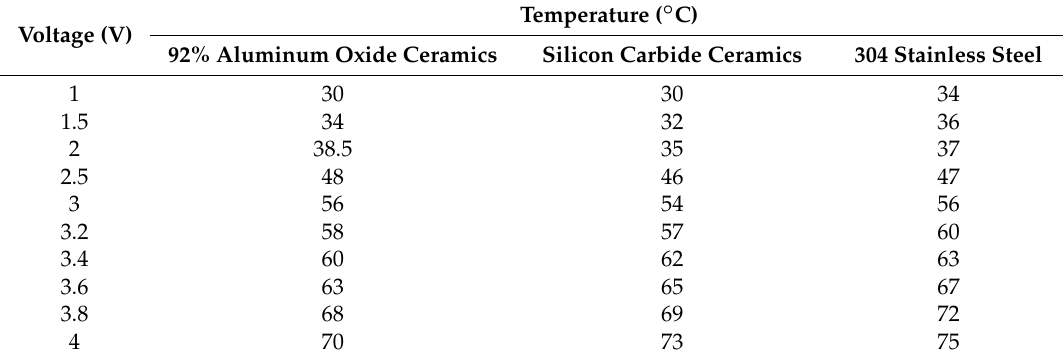
Figure 4. Temperatures of the high-temperature region of the thermoelectric cooler under different voltages and spacers. Table 1. Temperatures of the low-temperature region of the thermoelectric cooler under different voltages and spacers.